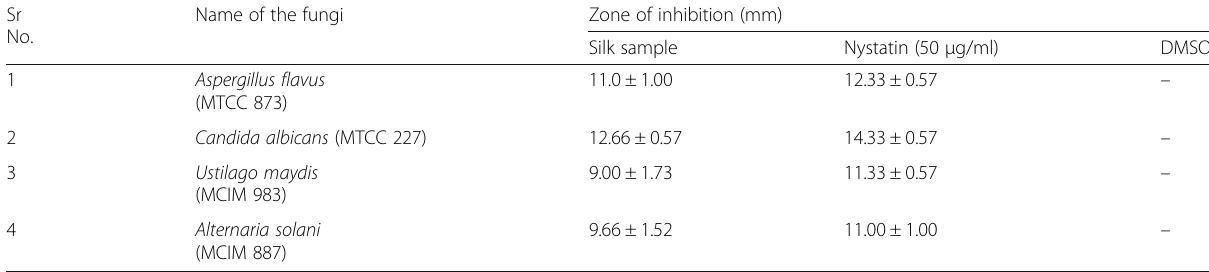
Table 4 Antifungal activity of DMSO fraction of spider